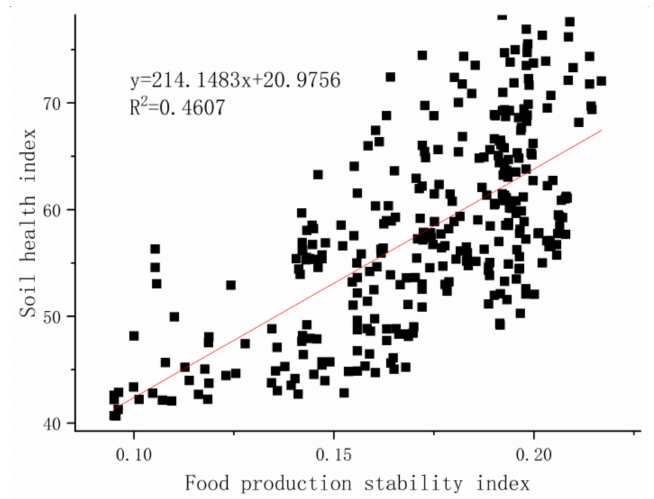
Figure 7. Correlation between food production stability index and